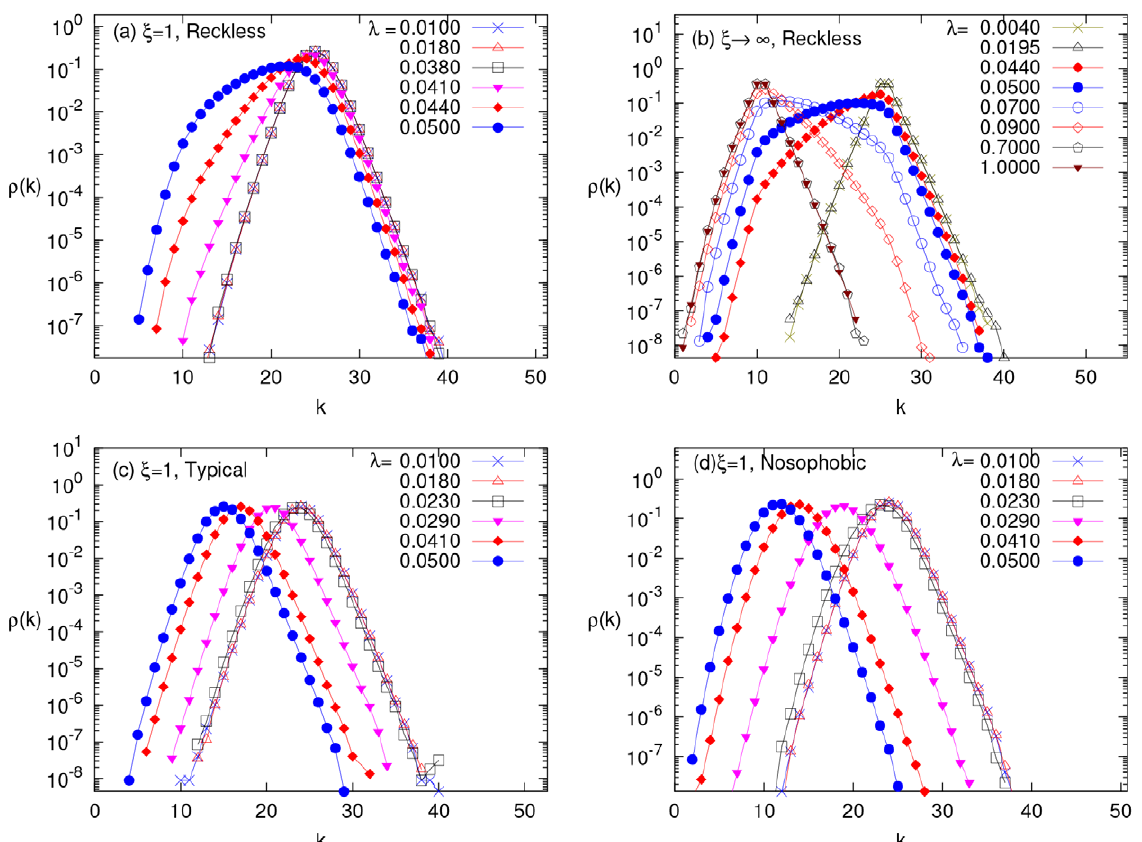
Figure 5. Steady state degree distribution of adaptive network. Degree distribution of (a) reckless with j ~ 1 (see Eq. 1) (b) reckless and inflexible individuals ( j ~ ? ), (c) Typical and (d) Nosophobic individuals (see Sec 3.A for details) with j ~ 1 . We have chosen N ~ 5000, k 0 ~ 25, k min ~ 10 for all these cases. The infection rates l are chosen to illustrate transition behavior in degree distributions.